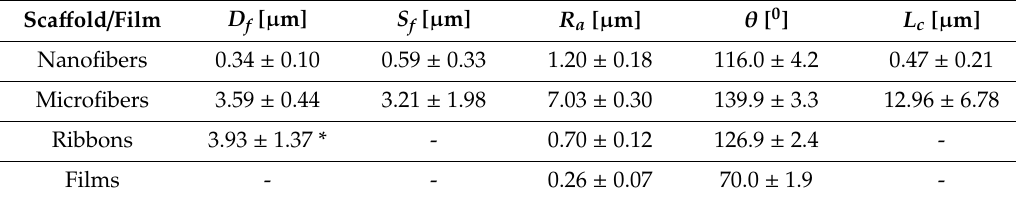
Table 2. The summary of all measurements performed on the PMMA samples and cells, including the average diameter of fiber ( D f ), average roughness ( R a ), the average distance between fibers ( S f ), and the water contact angle ( θ ), on all PMMA surfaces; and the filopodia length, after 3 days of cell culture ( L c